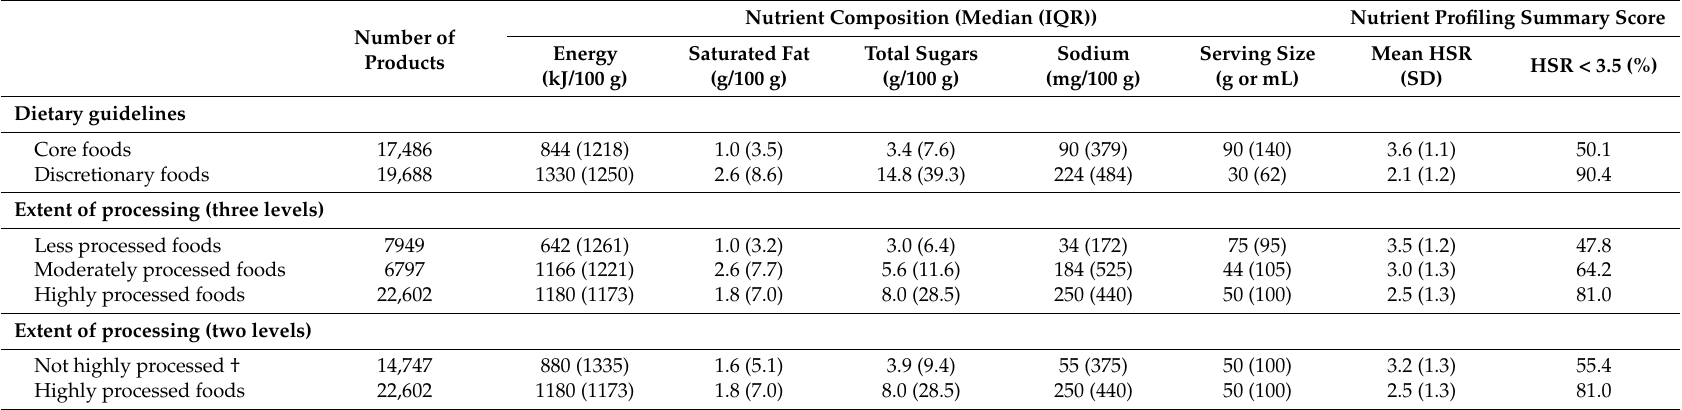
Table 4. Assessment of nutritional quality of the Australian packaged food supply by ‘core’ and ‘discretionary’ classification and extent of food processing